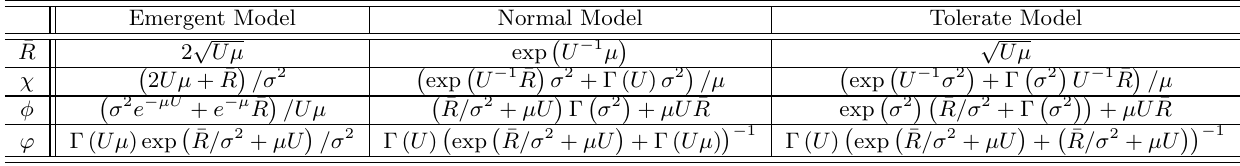
Table 1: Different function expressions under different